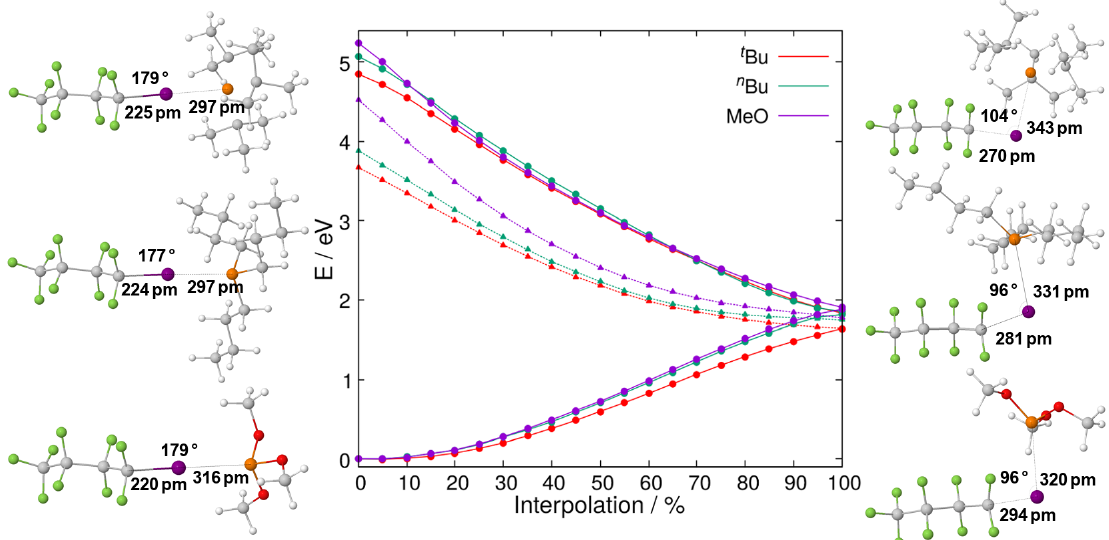
Figure 8. Energy profiles of the ground and first excited singlet states (solid lines) and the first excited triplet states (dotted lines) of the phosphine–IC 4 F 9 adducts along linearly interpolated paths connecting the S 0 minimum (left, 0%) and the optimized S 1 geometry (right, 100%).